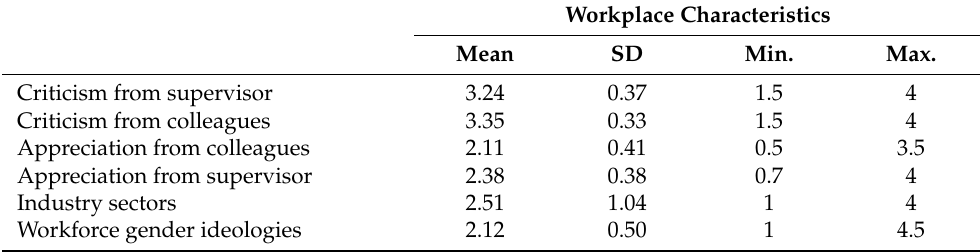
Table 2. Workplace-level descriptive